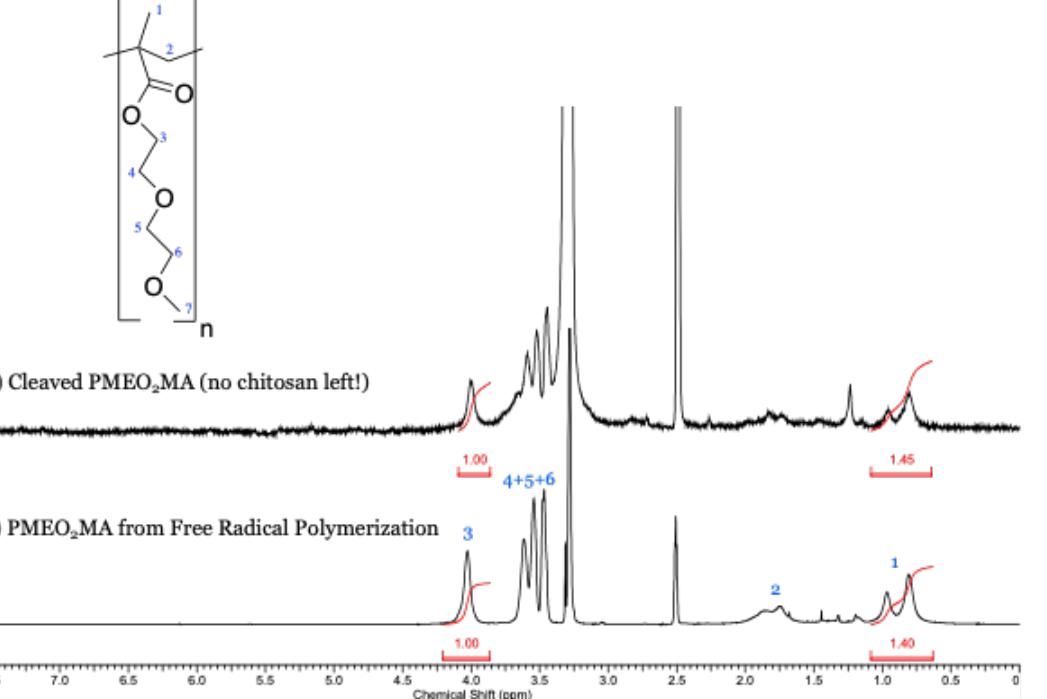
Figure 2. 1 H NMR spectra for ( a ) PMEO 2 MA and ( b ) PMEO 2 MA chains cleaved from Chito-g- PMEO 2 MA (15 wt %) in DMSO-d 6 at 25 °C.